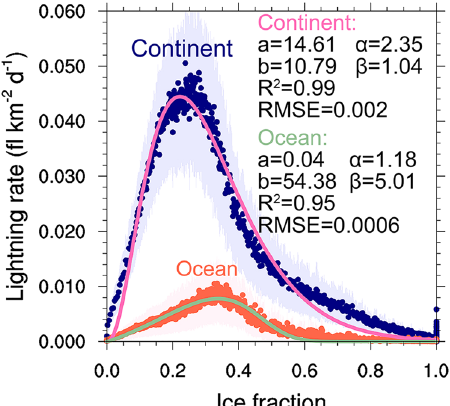
Fig. 2 Scatter plots of lightning fl ash rate versus cloud ice fraction on the global scale. The continental and oceanic regions are showing with blue and orange points, respectively. In addition, the regressions for lightning fl ash rate and cloud ice fraction are made for the continental (pink curve) and oceanic (green curve) regions, and the fi tting coef fi cients (a, α , b, and β in Eq. (1) ( “ Methods ” )) are presented in the fi gure. R 2 and RMSE are goodness-of- fi t index and root mean square error, respectively. The shaded areas of light blue and light orange indicate the error bars (10 times the standard errors) of the continental and oceanic regions, respectively.